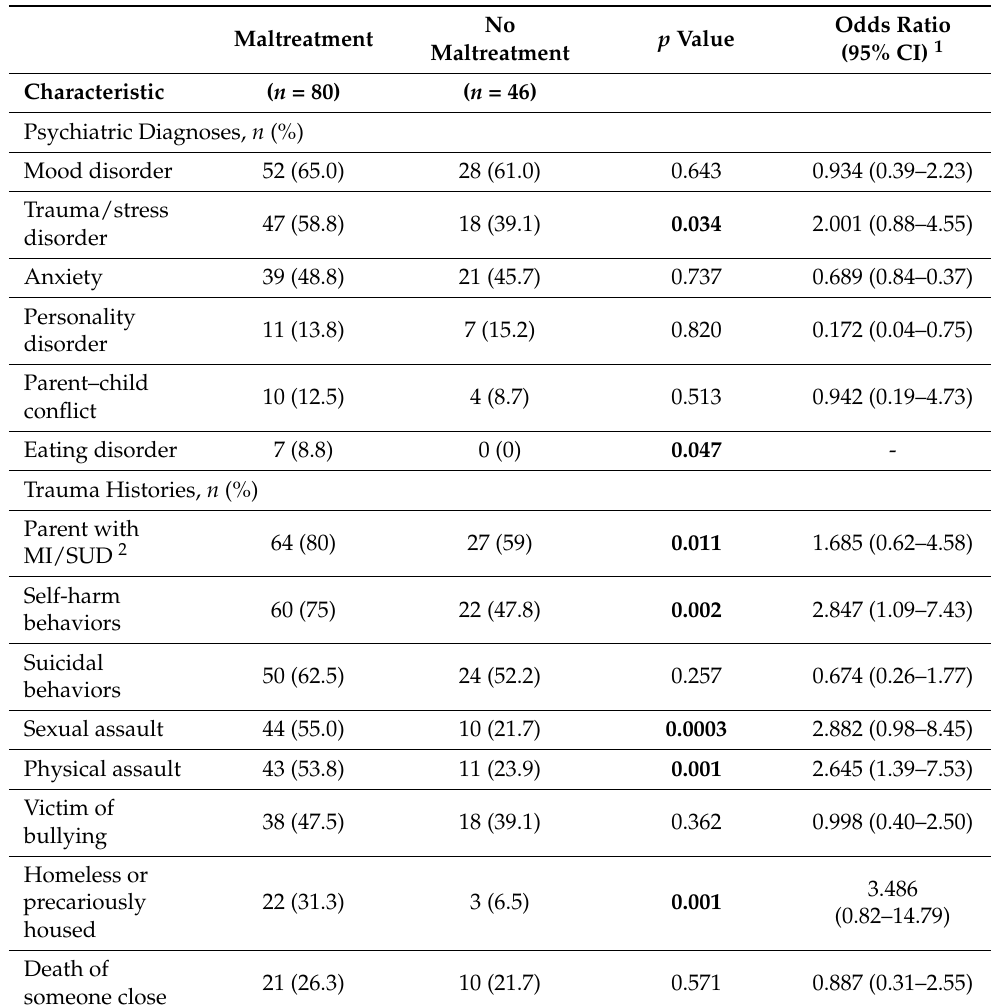
Table 2. Clinical and Psychosocial